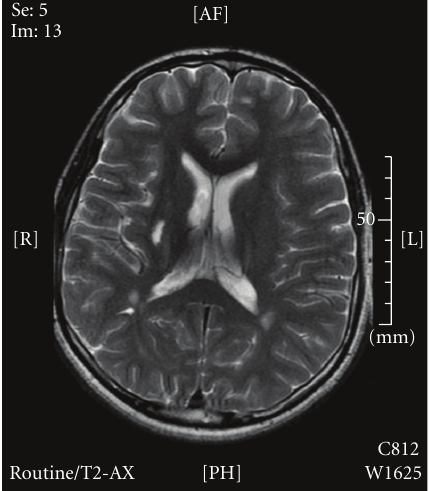
Figure 6: MRI 3 month after the initial insult showing a residual hyperdense signal abnormally in the periventricular